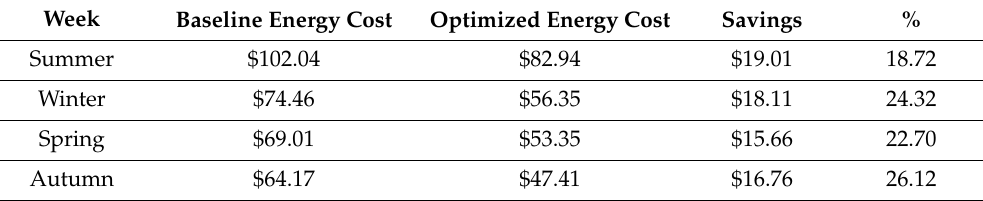
Table 3. Scenario 1 weekly savings.